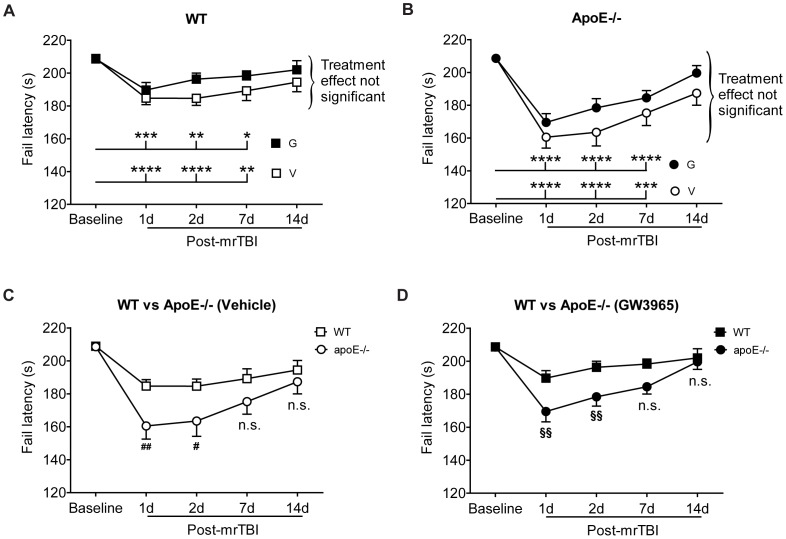
mrTBI-induced motor impairment recovers spontaneously independent of GW3965 and apoE.Motor performance of WT (n = 38) and apoE−/− (n = 30) mice was evaluated by the accelerating rotarod task (0 to 30 rpm in 210 s). (A) Rotarod latencies of untreated (V, open squares) and GW3965-treated (G, black filled squares) WT mice before and following mrTBI. (B) Rotarod latencies of untreated (V, open circles) and GW3965-treated (G, black filled circles) apoE−/− mice before and following mrTBI. Asterisks in A and B denote significant differences between baseline and post-mrTBI latencies within each group. For both genotypes, the treatment effect was not significant at any post-TBI time point (curly brackets). (C) Rotarod latencies of untreated WT (open squares) and apoE−/− (open circles) mice before and following mrTBI. (D) Rotarod latencies of GW3965-treated WT (black filled squares) and apoE−/− (black filled circles) mice before and following mrTBI. # and § in C and D denote significant differences between the latencies of WT and apoE−/− mice at the respective time points. Cohorts were: Untreated WT mice: (1 d = 34, 2 d = 34, 7 d = 24; 14 d = 14); GW3965-treated WT mice: (1 d = 35, 2 d = 35, 7 d = 25, 14 d = 14); untreated apoE−/− mice: (1 d = 24, 2 d = 24, 7 d = 20, 14 d = 9), and GW3965-treated apoE−/− mice: (1 d = 27, 2 d = 22, 7 d = 20, 14 d = 9). Data were analyzed using two-way repeated measures ANOVA followed by a Bonferroni post hoc test. *: p<0.05, **: p<0.01, ***: p<0.001, ****: p<0.0001, #: p<0.05, ##: p<0.01, §§: p<0.01.